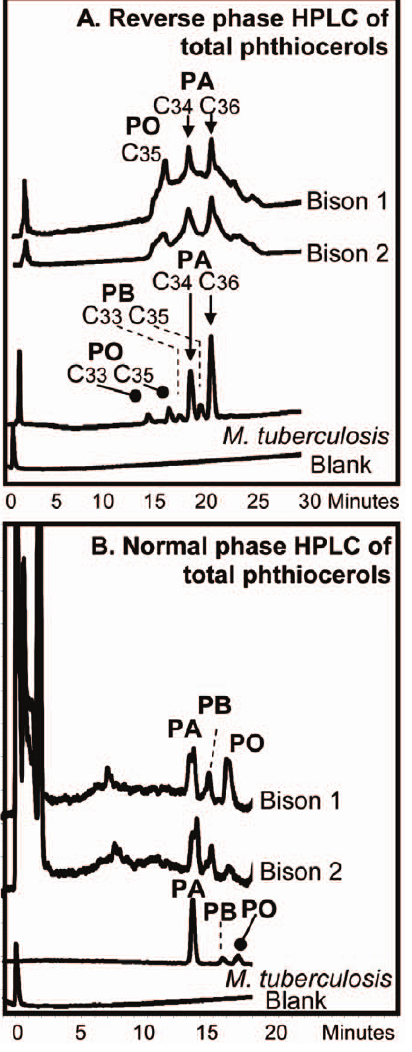
Figure 5. Fluorescence HPLC of di-pyrenebutyric acid deriva- tives of members of the phthiocerol family. The derivatives analysed were from Bison 1 and Bison 2 bones and standard M. tuberculosis . A. Reverse phase HPLC of total phthiocerol family fraction. B. Normal phase HPLC of phthiocerol family derivatives collected from reverse phase separations. Abbreviations: PA , phthiocerol A; PB , phthiocerol B; PO , phthiodiolone.